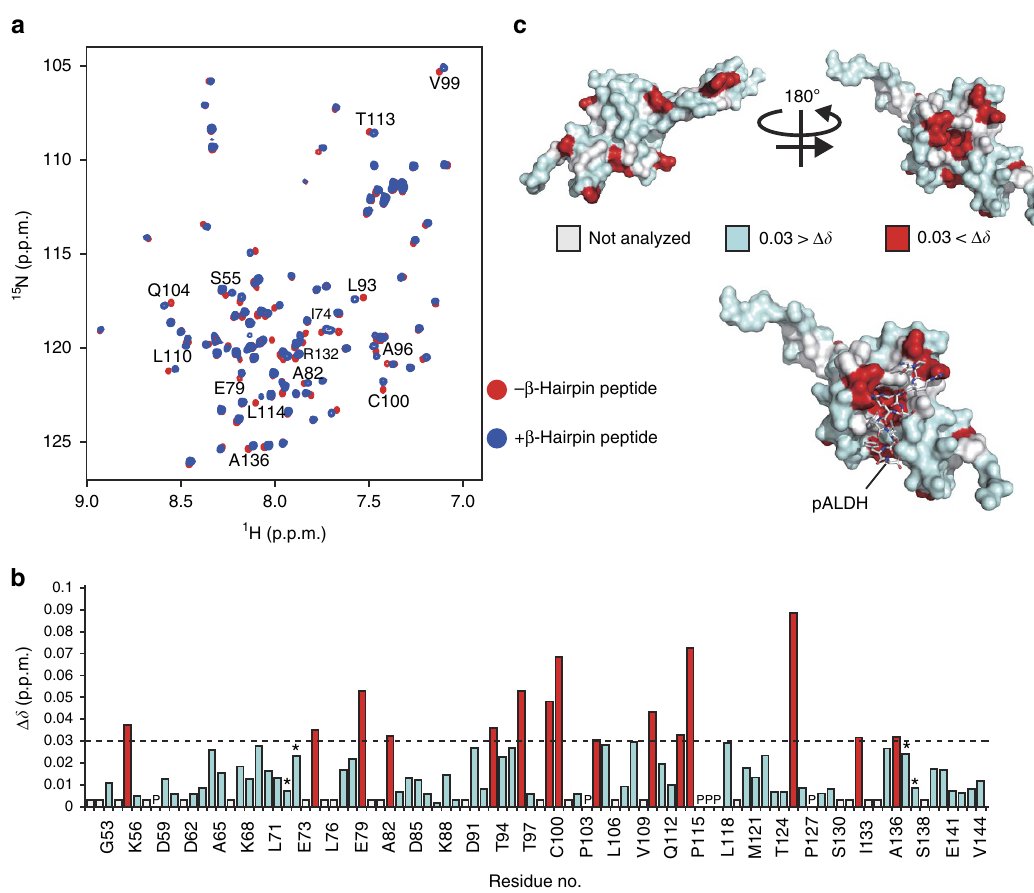
Figure 9 | The b -hairpin peptide binds to the presequence binding region of Tom20. ( a ) [ 1 H, 15 N]-HSQC NMR spectra of [ 15 N]-labelled rat dTom20 were recorded before (red spectrum) and after addition of two molar excess cyclic peptide (as in Fig. 1a) in DMSO (blue spectrum) or the same volumes of DMSO as control. ( b ) The chemical shift changes of each backbone amide of dTom20 in ( a ) are presented. Signals from several amino acids were not used for the analysis due to signal overlapping. The signals from some other residues were not assigned. These uncharacterized residues are shown in white. Signals showing chemical shift changes larger than 0.03 p.p.m. are shown in red and the others in pale blue. Asterisks, residues E72 and Q137 gave two signals each. ( c ) The residues whose signals show chemical shift changes larger or lower than 0.03 p.p.m. are shown in red and pale blue, respectively, on the surface model of rat dTom20 in a complex with the presequence peptide derived from rat aldehyde dehydrogenase (pALDH) (PDB ID 1OM2). The residues whose signals were not analyzed are shown in white. The structure of pALDH is shown as a stick model in the lower